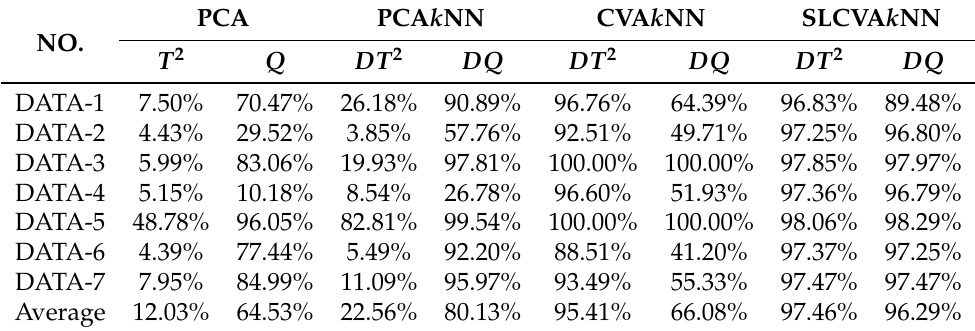
Figure 8. SLCVAkNN monitoring results on the DATA-6 case. Table 2. The disturbance detection rate of PCA, PCA k NN, CVA k NN, and SLCVA k NN for the tested data